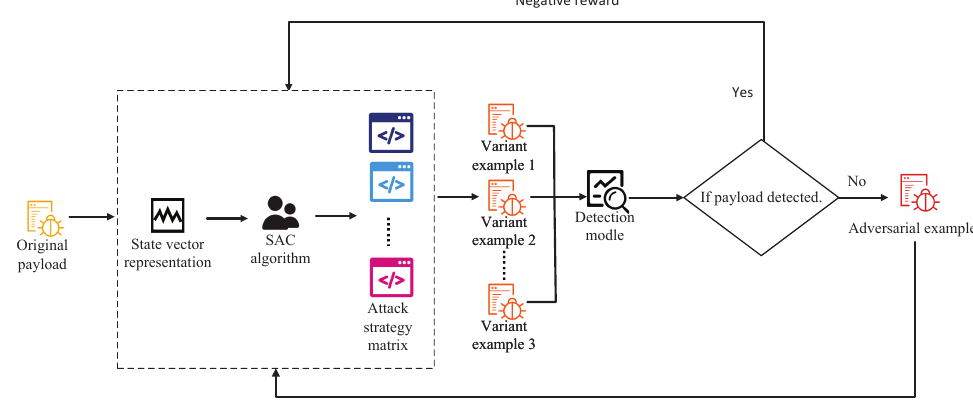
Figure 1. Framework of